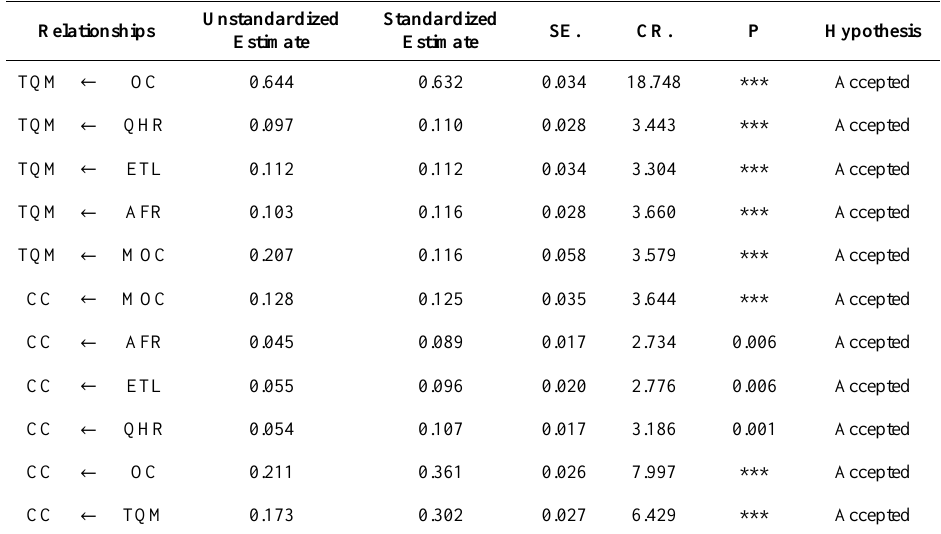
Table 3. Testing coefficients for factors affecting total quality management and competitive capability Unstandardized Standardized Relationships SE. CR. P Hypothesis Estimate Estimate